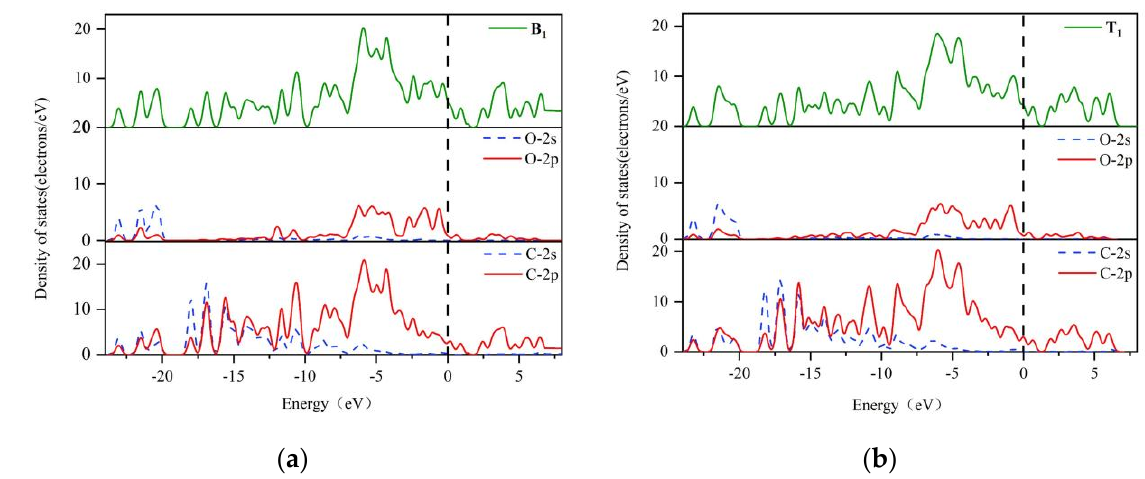
Figure 5. Total density of states and the projected density of states of oxygen and carbon atoms: ( a ) adsorb at B 1 site; ( b ) adsorb at T 1 site.